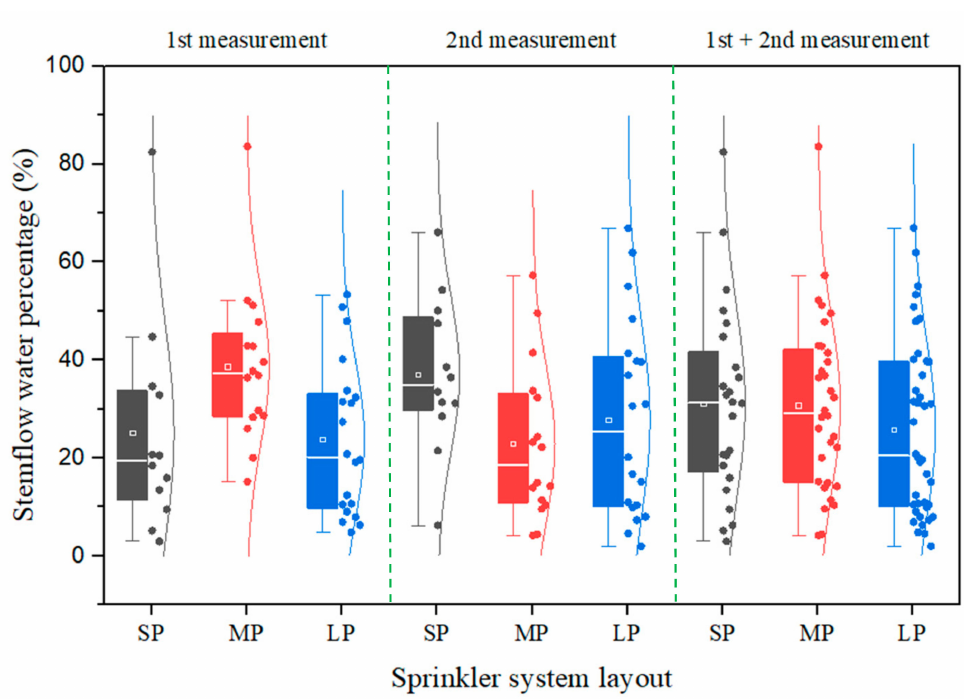
Figure 4. Distribution of the stemflow water percentage under the three sprinkler system layouts in the two measurements.